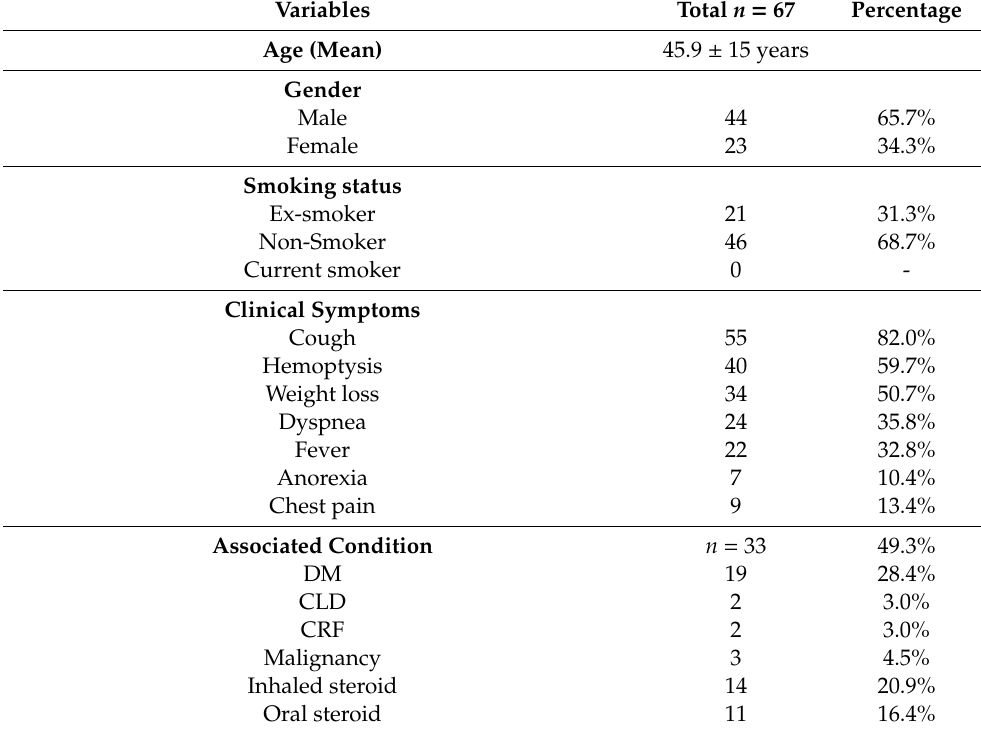
Figure 1. Patient enrollment. Table 1. Baseline characteristics of patients and diagnostic criteria of chronic pulmonary aspergillosis (CPA).